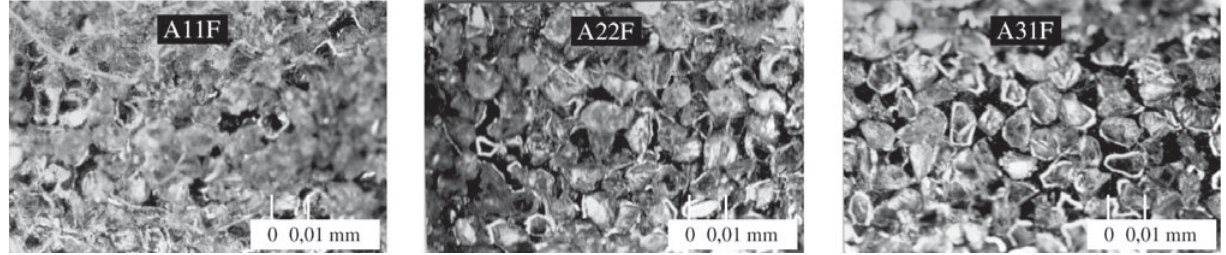
Figura 6. Superfície da ponta usinada após a realização dos ensaios, após uma, duas e três esterilizações em autoclave, respectivamente.